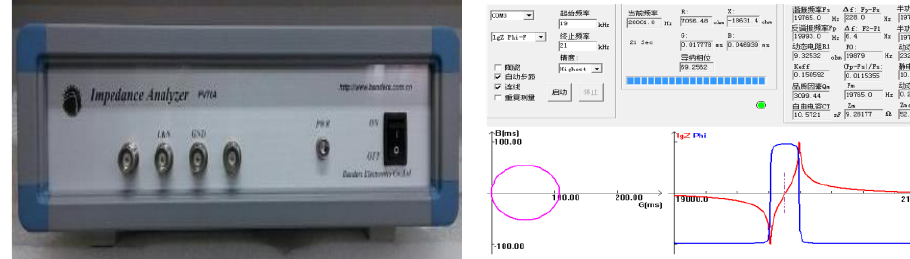
Figure 3. PV70A Ultrasonic Impedance Analyzer.